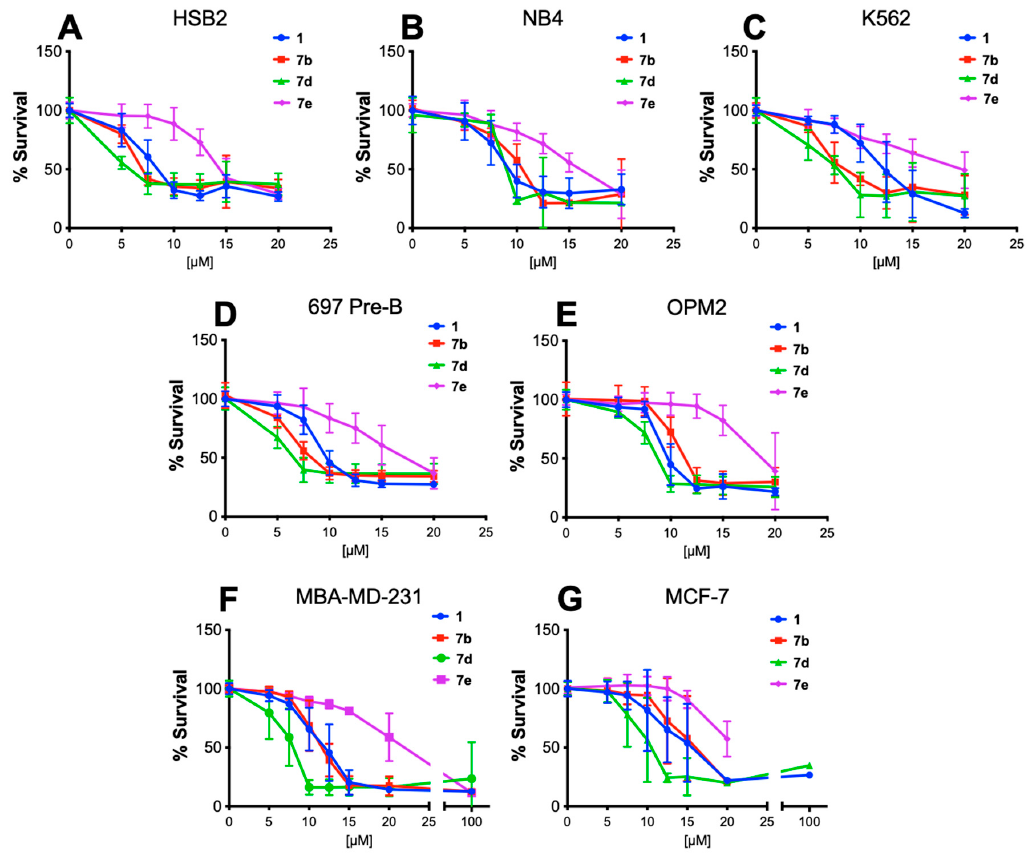
Figure 3. Activity of pan-SHIP1/2 Inhibitors against leukemia, multiple myeloma, and breast cancer cell lines. MTT assays show that some tryptamines kill tumor cell lines. Results are shown with connecting lines for clarity and expressed as mean ± standard error of the mean (SEM) of three individual